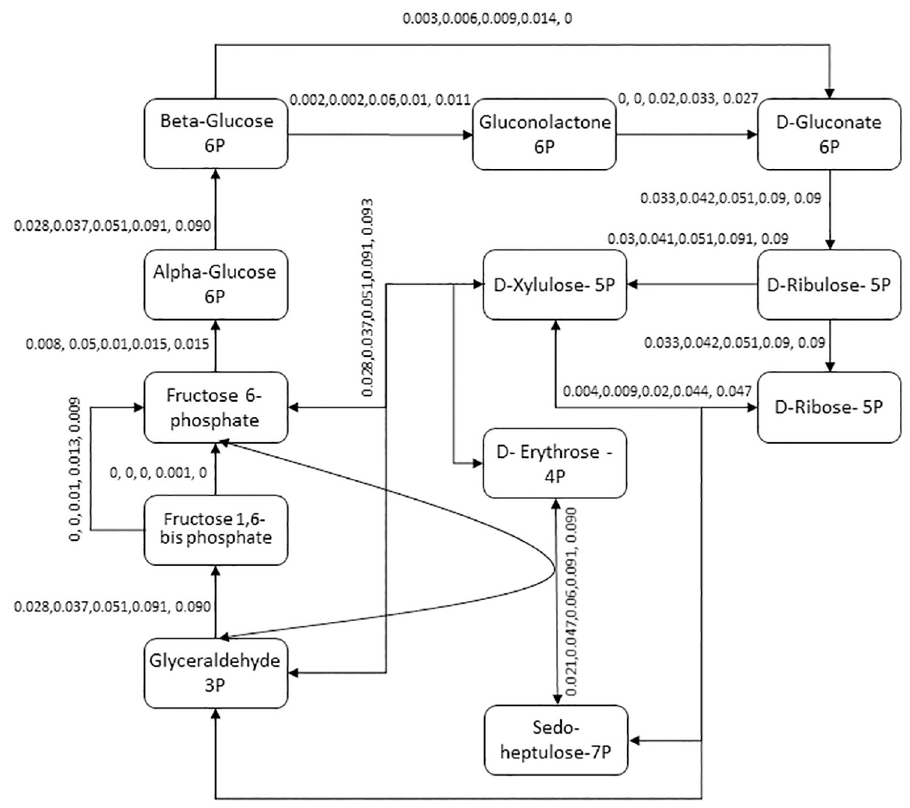
Fig 1. Pentose phosphate pathway in i MB631. For simplification, cofactors and byproducts are not shown. Each reaction’s flux is shown for glucose uptake rates of 0.5, 1, 2, 4 and 5 mmol/gDW/h. The cycle works in all 5 uptake rates. Though glycolysis pathway is presented in the model, no glucose uptake rate was found where all reactions have acceptable fluxes.